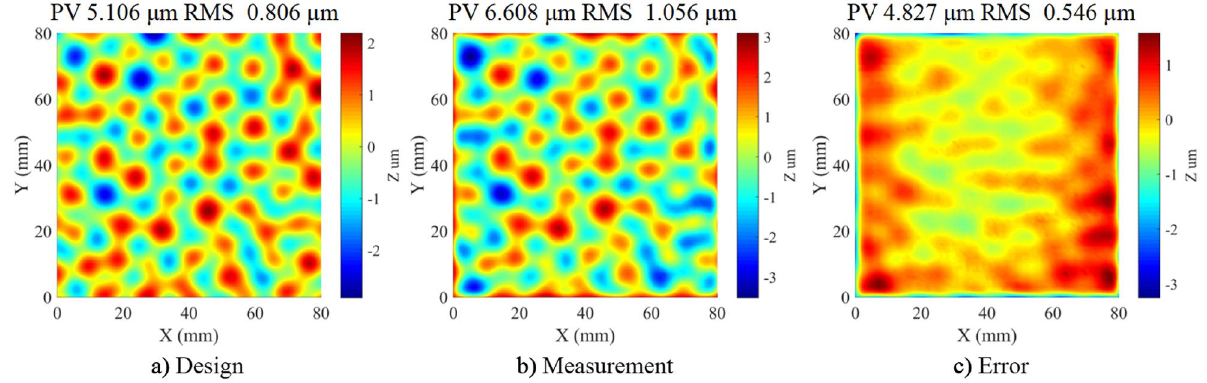
Figure 18. Continuous APPS experiment results of a 3D CPP pattern.